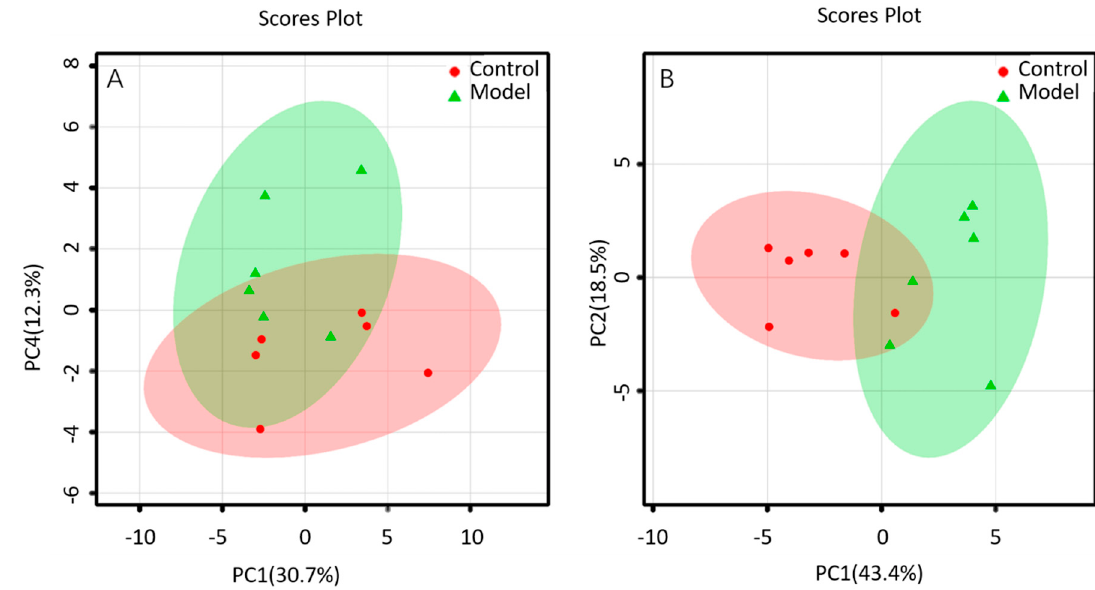
Figure 4. PCA of lipids in BALF of mice: ( A ) positive ion mod; ( B ) negative ion mod.